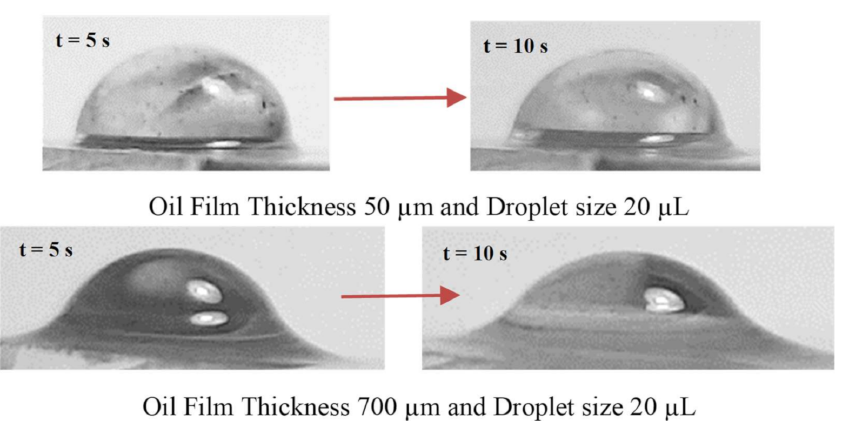
Figure 7. Optical image of silicon oil infusion on water droplet at different times. The time of droplet motion is started and recorded as the droplet is dispensed on the oil-impregnated sample surface. (cid:104) (cid:105) (cid:104) (cid:105) ∂ h 3 f ∂ h f = ∇· − L ∇· + = 0, where h h 3 ∇∇ 2 h f h 3 ∇ h f D f is the normalized film ∂ t ∂ x thickness ( h f / h c , here h f are the oil thickness and h c being the oil in the upstream of the film—maximum thickness), x represents the space along the inclined surface, and LD is the normalized parameter ( L D = ( 3 Ca ) 1/3 cot δ , here δ is the tilt angle of the surface). The nu- merical solution of the equation for the film velocity yielded that the film velocity was 0.02 mm/s for the film thickness 700 µ m and the tilt angle of 5 ◦ . The film velocity obtained by a tracker program using the high-speed recorded data was about 0.017 mm/s, which is closer to the numerical prediction. Moreover, since the crystallized surface, where the oil film was deposited, had a hydrophobic texture with 3.2 µ m average roughness, slip condition could occur across the textured surface and the oil film. The slip velocity can be formulated ( 1 − φ ) h through the slip length [35] ( b ∼ µ t , here µ being the droplet fluid viscosity, φ rep- µ o resents the solid fraction for crystallized surface, and h t is the film thickness) [30]. The solid fraction of the crystalized surface was evaluated via AFM and SEM micrographs and it was estimated at about φ = 0.35. Incorporating the viscosity of silicon oil (0.92 × 10 − 2 Pa.s) and water (0.89 × 10 − 3 Pa.s), film thickness (700 µ m), and a solid fraction, the slip length τ o − s , here yielded about b = 44 µ m. Moreover, the slip velocity can be written as; u s = b µ τ o − s is the interfacial shear stress across the oil and the crystallized surface [30], which can be further simplified after considering a Couette flow in clearance between the bottom of the droplet and oil. Hence, the slip velocity in terms of film velocity and the slip length u f . Moreover, the velocities of the partially immersed droplet and the yielded: u s ∼ b h t oil film were different, which created a shear resistance across the droplet and the oil. ( V ) d − u f The frictional stress can be; ∼ µ l m and l m is the height between the droplet base and the droplet mass center [36]. It is also known that shear stress in between the textured surface and the oil can be approximated as ) ( u f − u s ∼ µ o h t (stress continuity). This yields the relation between the slip and the droplet velocities,